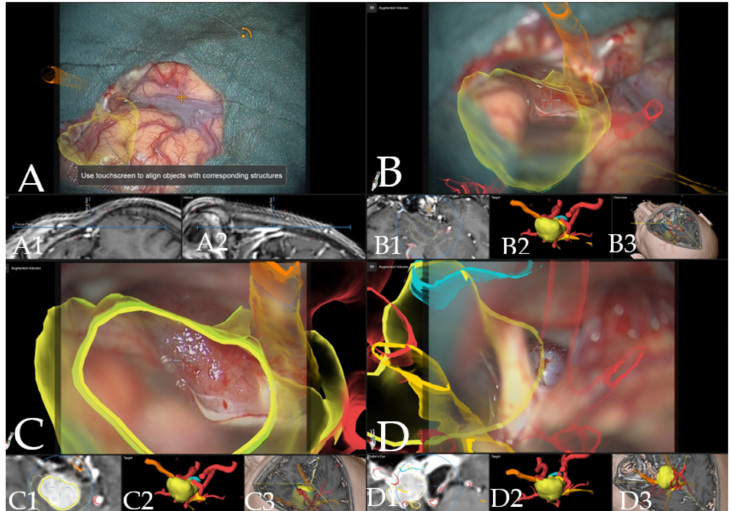
Figure 7. Navigation and augmented reality support during surgery (patient no. 19, same patient as in Figure 1). ( A ) Three-dimensional visualization of the segmented objects as seen through the micro- scope video with head up display (tumor in yellow, optic chiasm and optic nerves in orange), showing navigation update after craniotomy with focus on Sylvian fissure in ( A1 ) axial and ( A2 ) coronal view of the standard navigation. ( B ) Three-dimensional visualization of segmented objects (with vessels in red) following retraction of the frontal lobe with ( B1 ) corresponding probe’s eye view, ( B2 ) target view and ( B3 ) overview depicting the video plane in relation to the segmented objects in 3D fashion. ( C ) Microscope video of tumor exposure with head-up display with ( C1 ) corresponding probe’s eye view, ( C2 ) target view and ( C3 ) overview of the video plane. ( D ) AR display on video screen with the 3D outline of tumor, carotid arteries, optic nerves and chiasm with focus on the carotid artery, follow- ing complete resection of the tumor with ( D1 ) probe’s eye view, ( D2 ) target view and ( D3 ) overview of the video